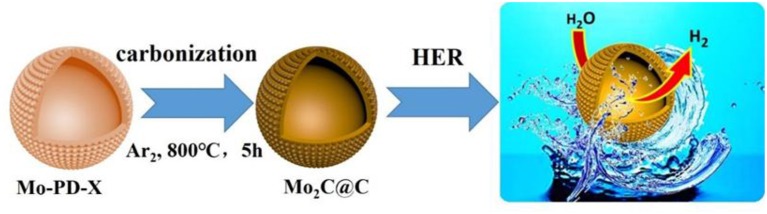
Schematic illustration for the synthesis of hollow porous Mo2C@C nanoball catalysts.